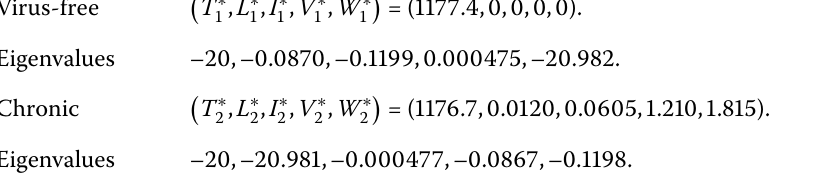
Table 11 Sensitivity indices for T ∗